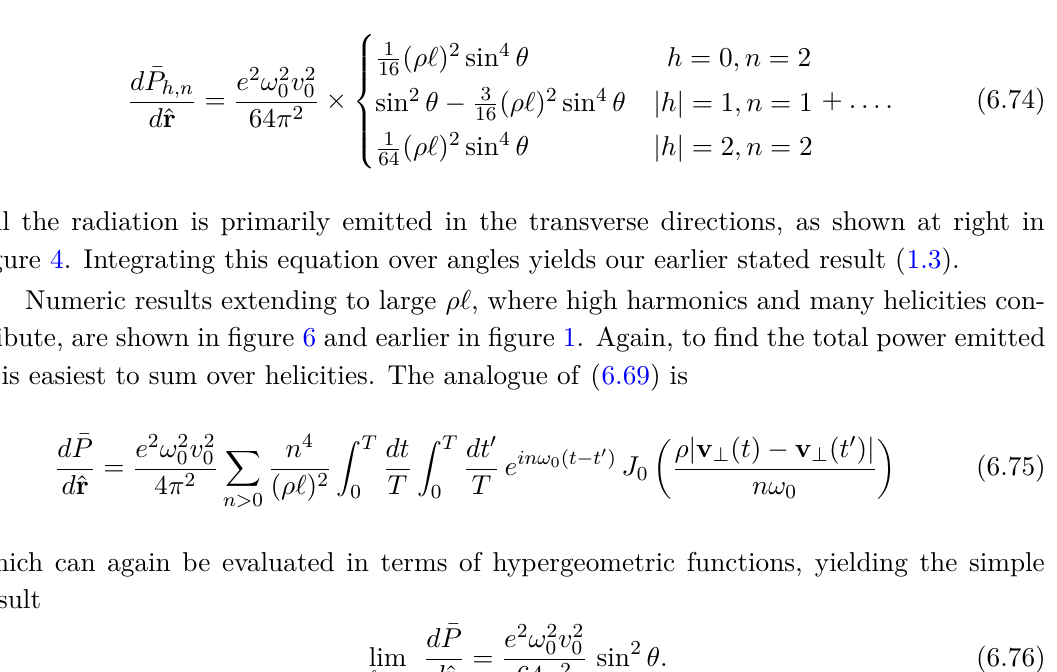
Unlike the scalar-like case, this expression also contains the usual ρ -independent amplitude, since it appears at the same order in v as the leading corrections. The leading contribution 0 to the radiation amplitude at helicity h is of order v ( ρ‘ ) || h |− 1 | , and the radiated power 0